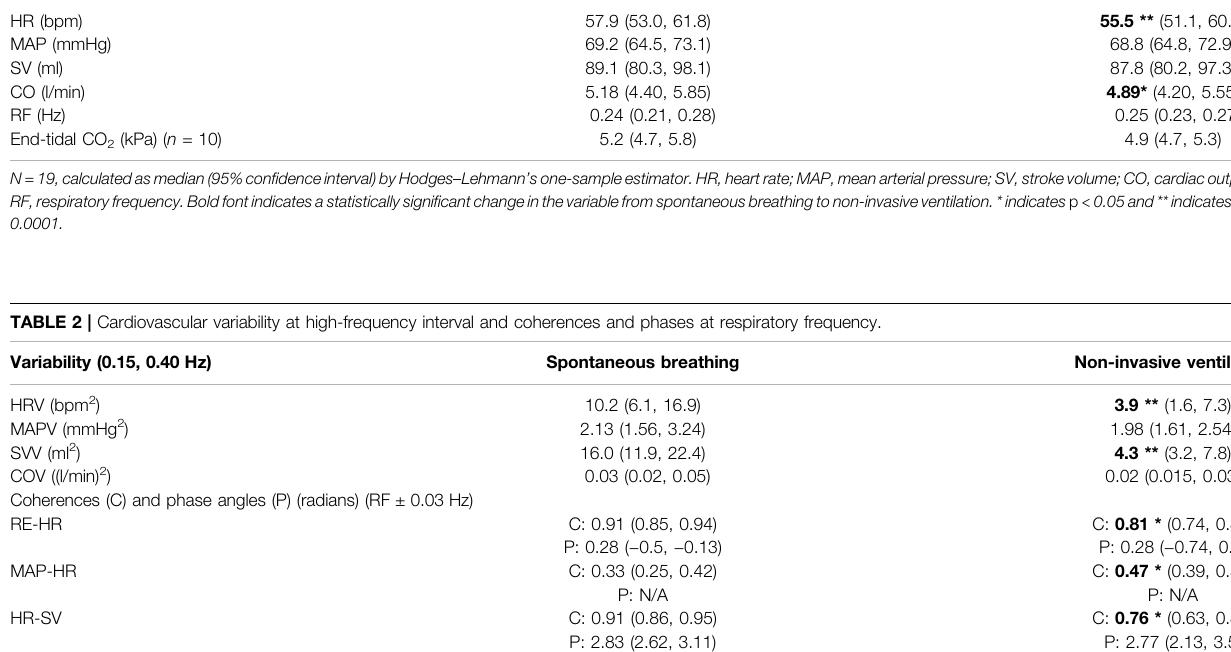
TABLE 1 | Cardiovascular variables and respiratory frequency during spontaneous breathing and non-invasive ventilation. Variable